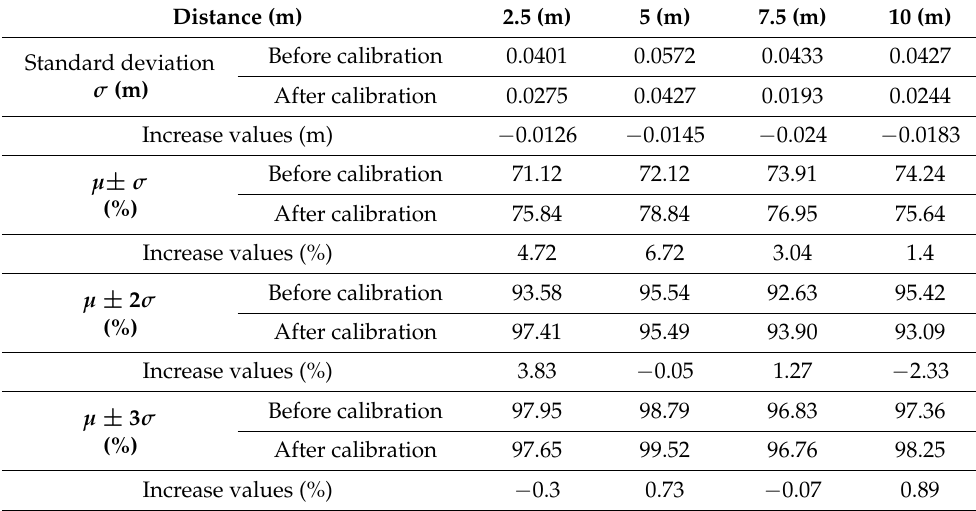
Table 3. The standard deviation of P2P-D and the percentage within σ , 2 σ , 3 σ confidence intervals at different